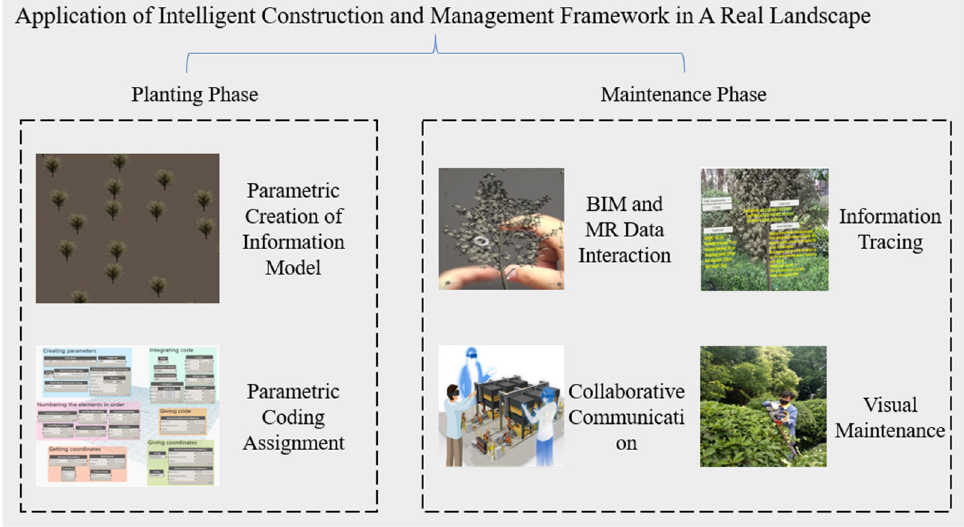
Figure 8. Application of intelligent construction and management framework in a real landscape.